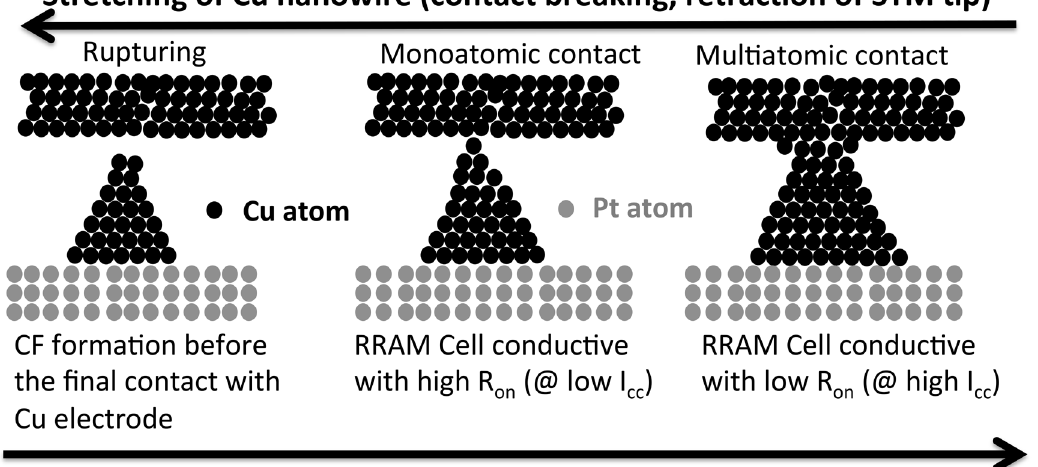
Figure 5. Equivalency between making a monoatomic contact by elongation of an indented Cu wire in a free space and formation of a chain of Cu atoms in the matrix of a thin dielectric (TaO x ) in a ReRAM cell and electrochemical deposition in CuSO 4 ion solution and a method for monoatomic contact formation using Scanning Transmission Microscope (STM). For both types of point contact fabrication, quantization of conductance in units G o = 2e 2 /h has been observed in large number of publications cited in this paper.